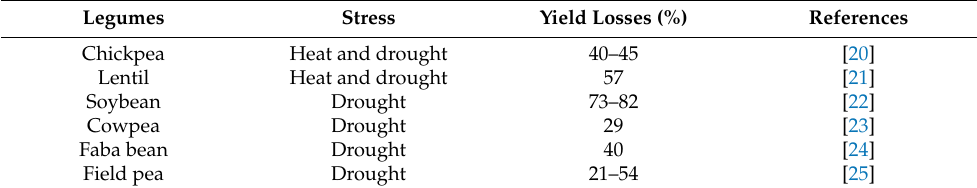
Table 1. Yield losses caused by drought and heat stress in some major food legumes.